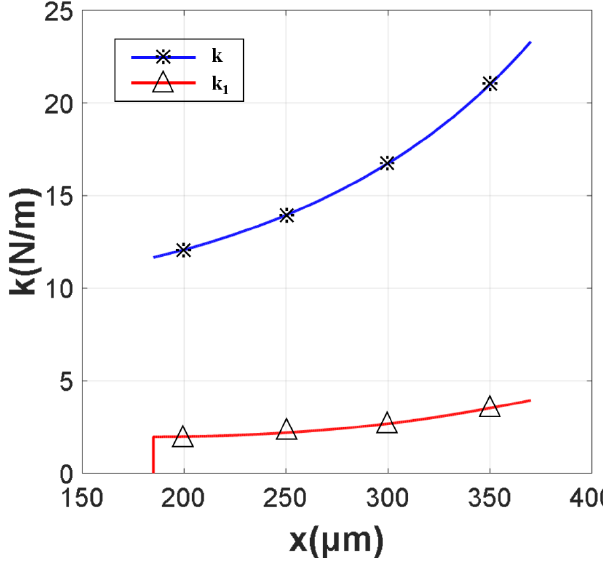
Figure 8. The relationship between 𝑥 and 𝑘 1 , 𝑘 .